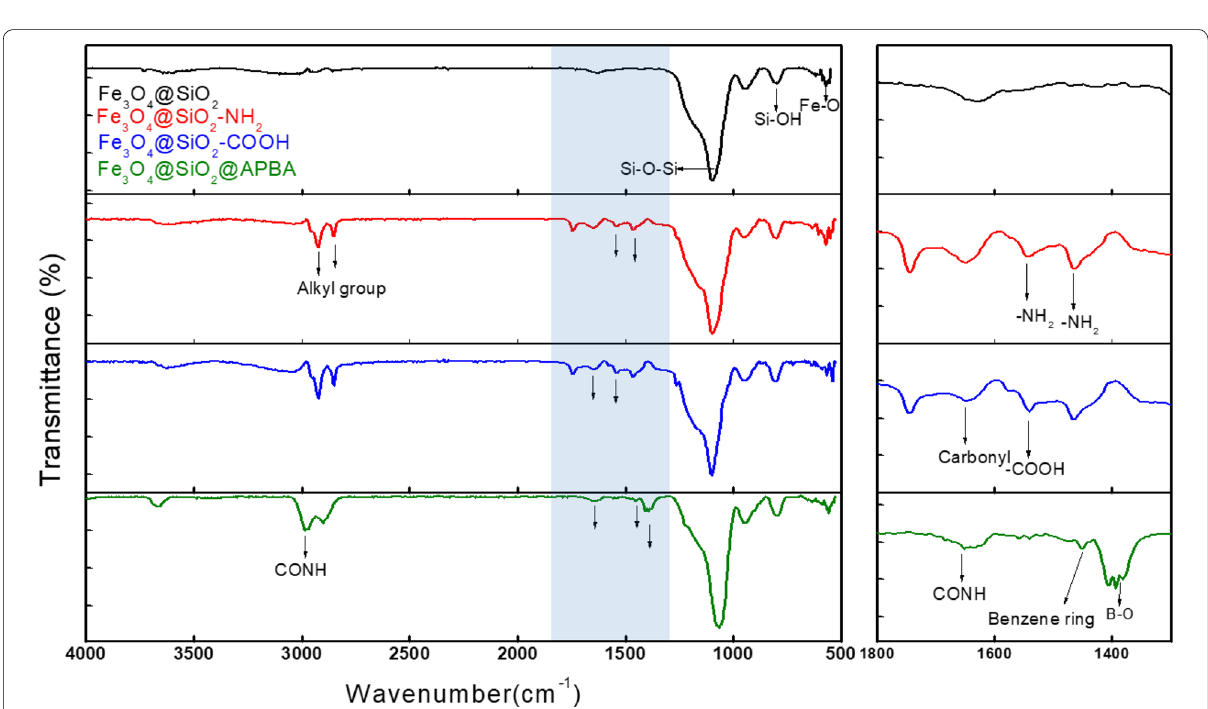
Fig. 2 Fourier‑transform infrared spectra of as‑prepared